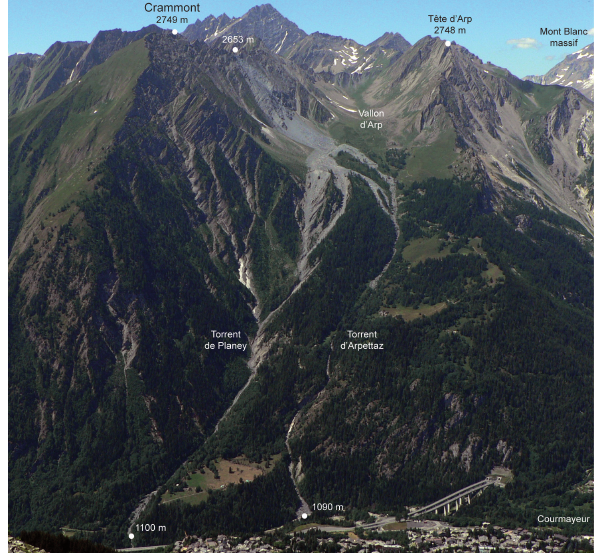
Fig. 1. Location of the study area. Glaciers from Corine Land Cover 2000 (Swiss glaciers only represented in the Mont Blanc massif).